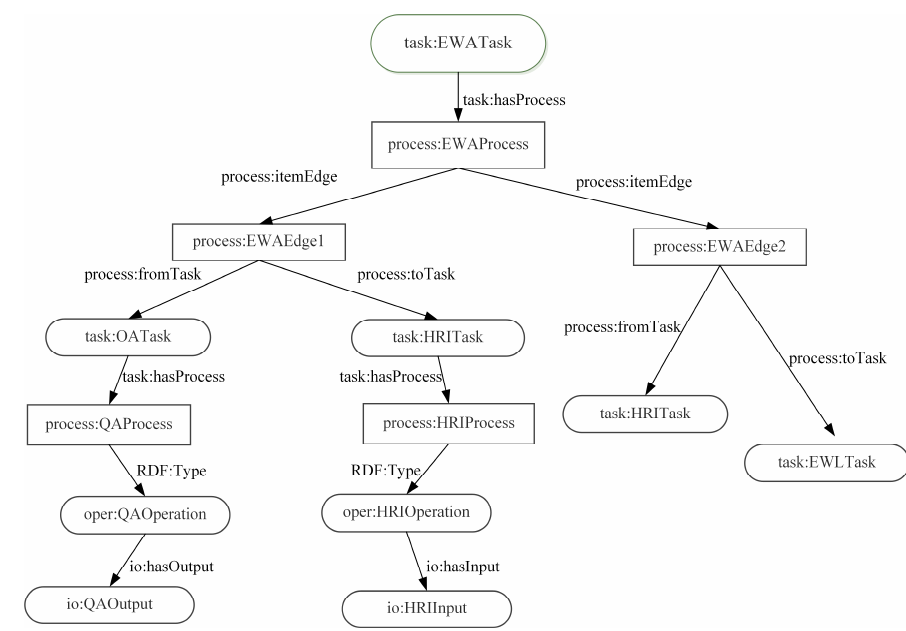
Figure 10. The task instance of an atomic task (EffectiveRainfallCalTask). ISPRS Int. J. Geo-Inf. 2018 , 7 , x FOR PEER REVIEW